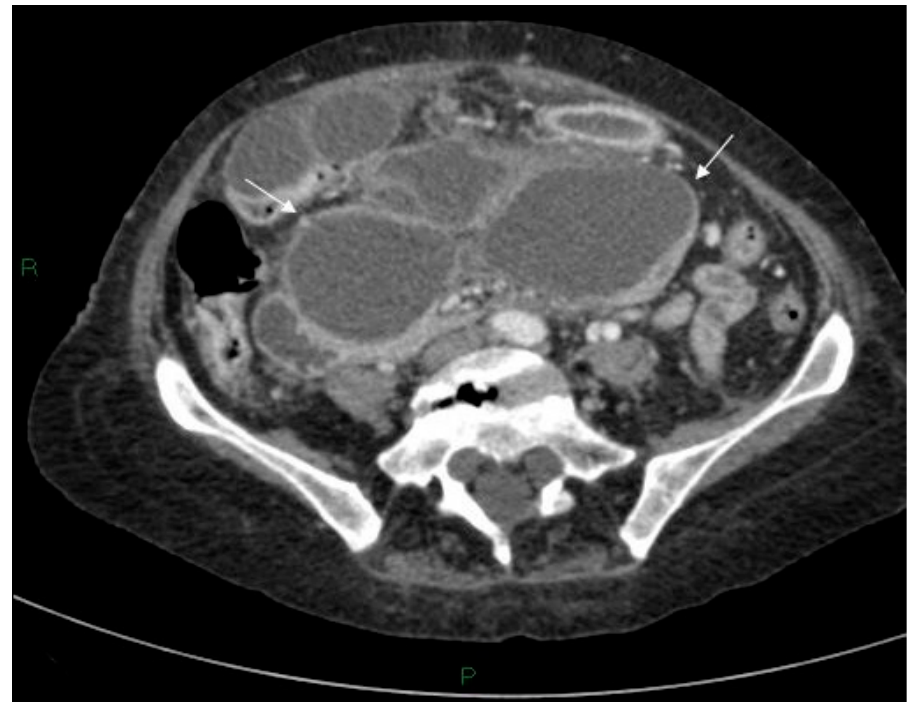
Figure 2 Axial post-contrast CT scan of the upper abdomen showing the inferior aspect of the cyst with bi-lobed appearance (arrows) in the pelvis.